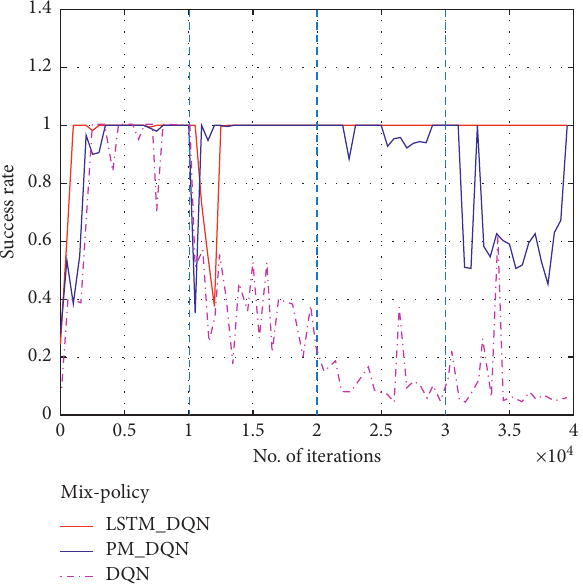
Figure 10: Relationship between the number of iterations and success rate